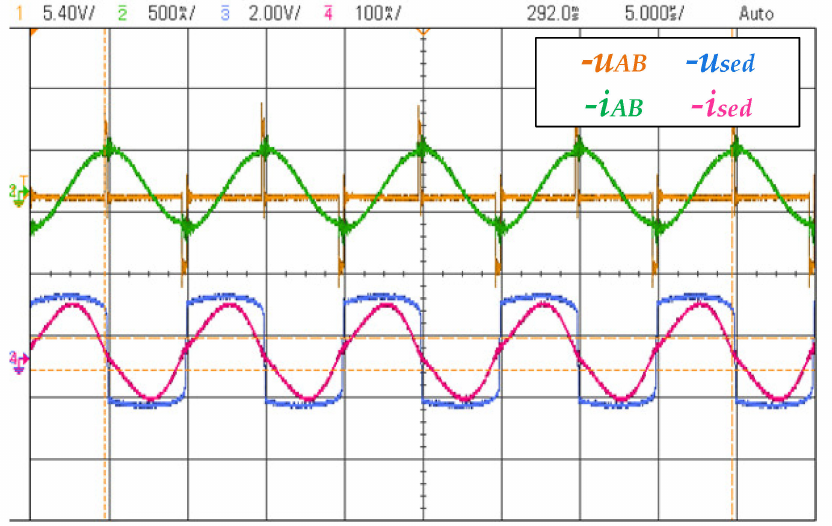
Figure 20. Waveforms of the current and voltage on the primary and secondary sides of the resonator without using auxiliary